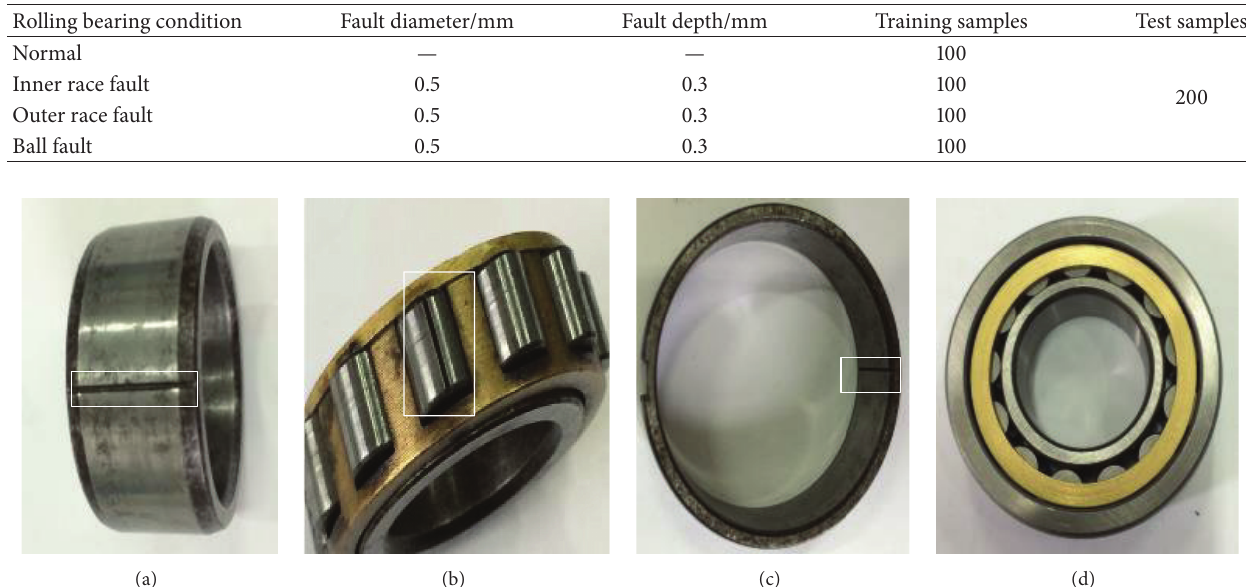
Table 2: Sample distribution of normal and different faults.